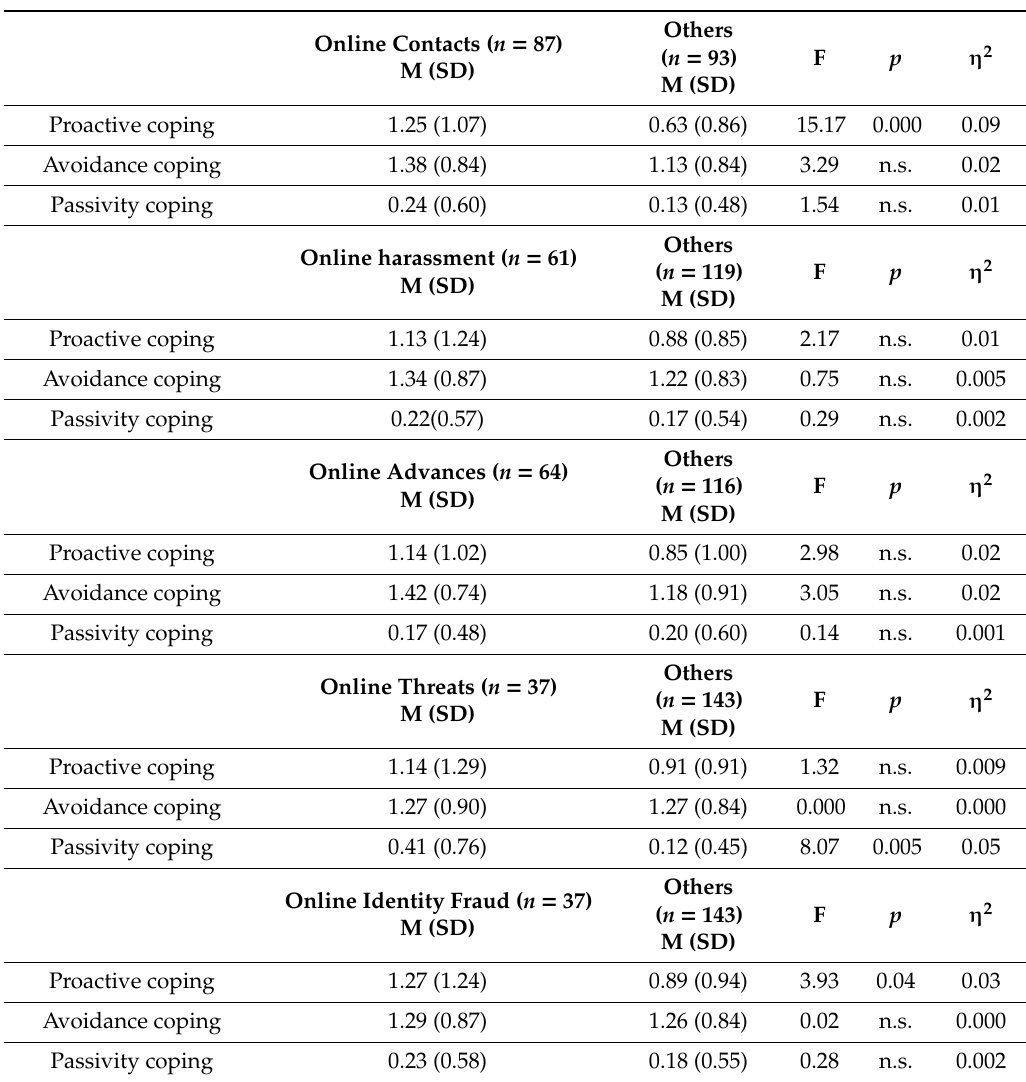
Table 4. Coping strategies: comparison on the basis of di ff erent forms of cyberstalking (one-way